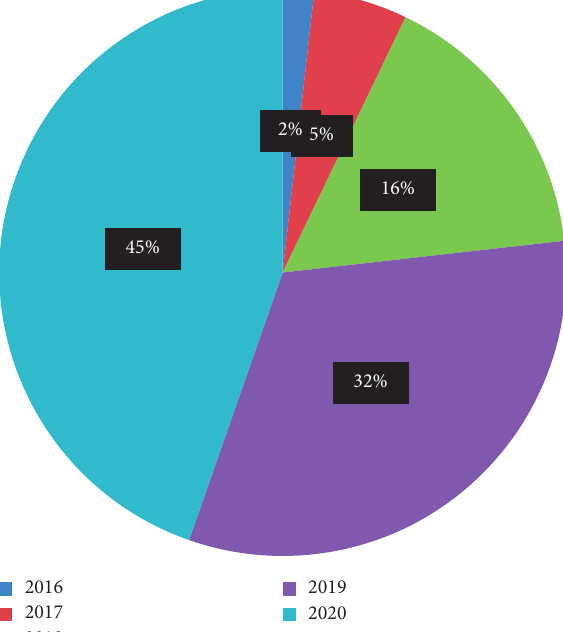
Figure 10: Overall articles in the specified years with total